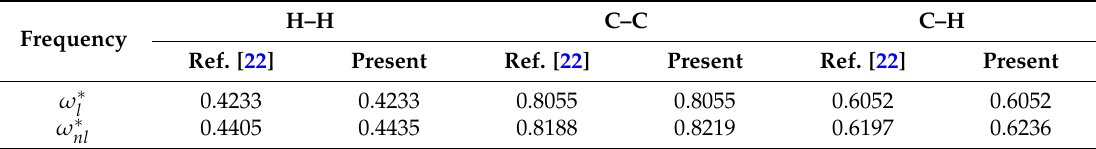
Table 3. Comparison of linear and nonlinear dimensionless frequency of a straight nonlocal nano-beam with µ = 0.15 and w ∗ max =